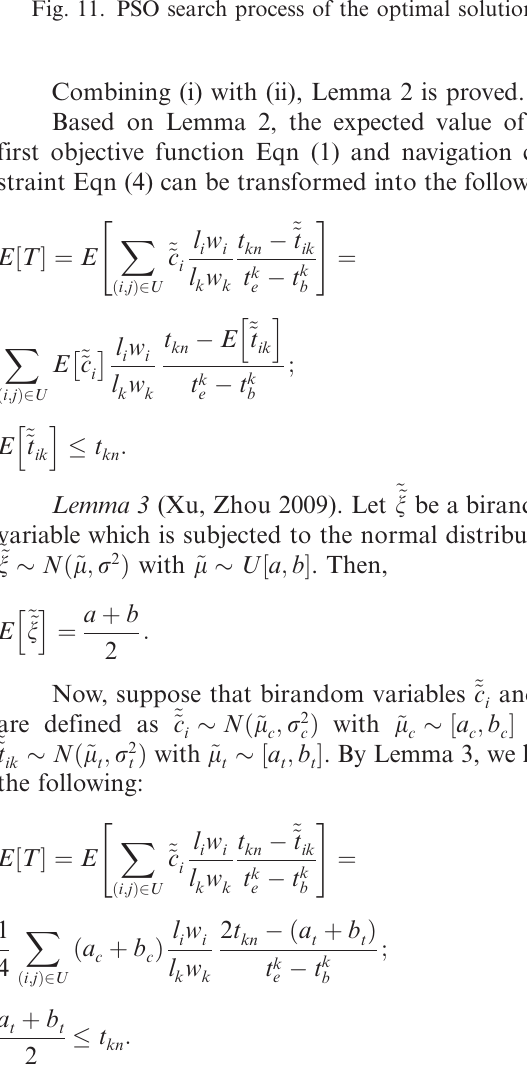
Fig. 11. PSO search process of the optimal